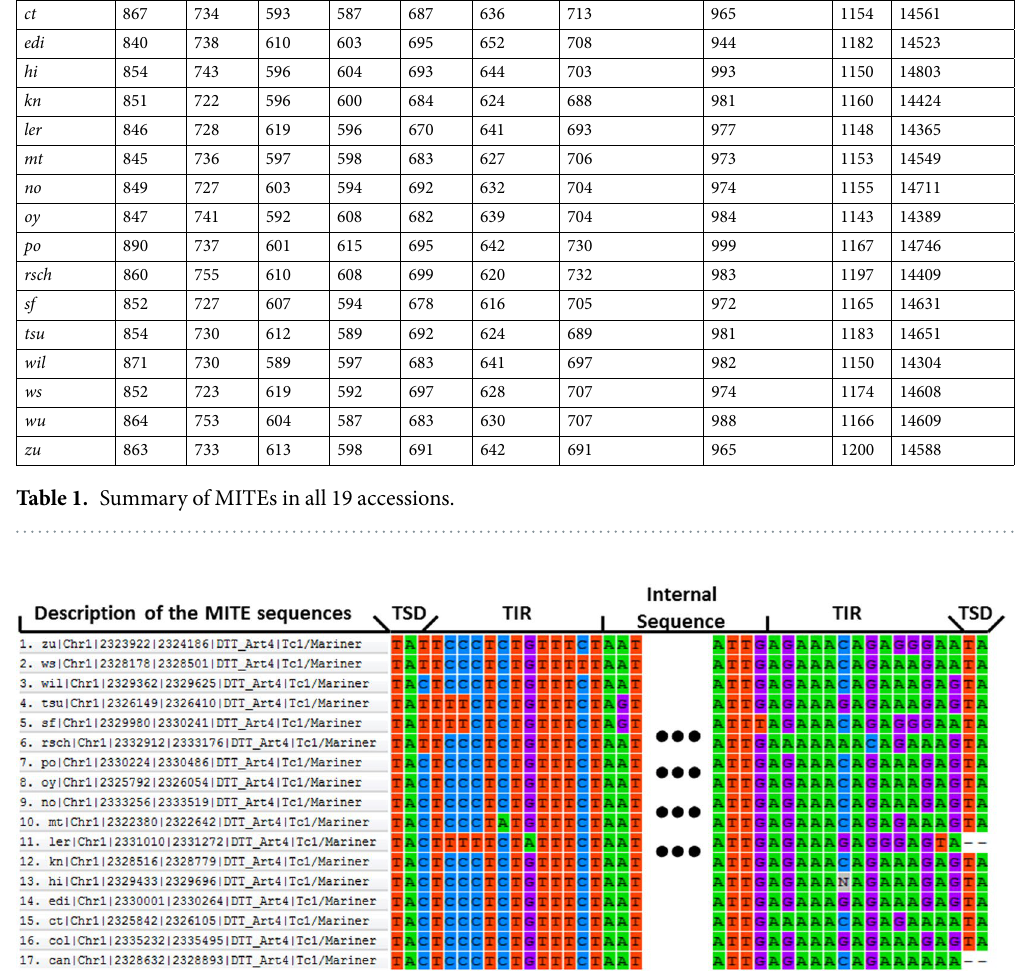
Figure 2. Multiple sequence alignment for a homologous MITE group by MEGA6. The description of the MITE sequences column includes the basic MITE information, placed in descending order of accession